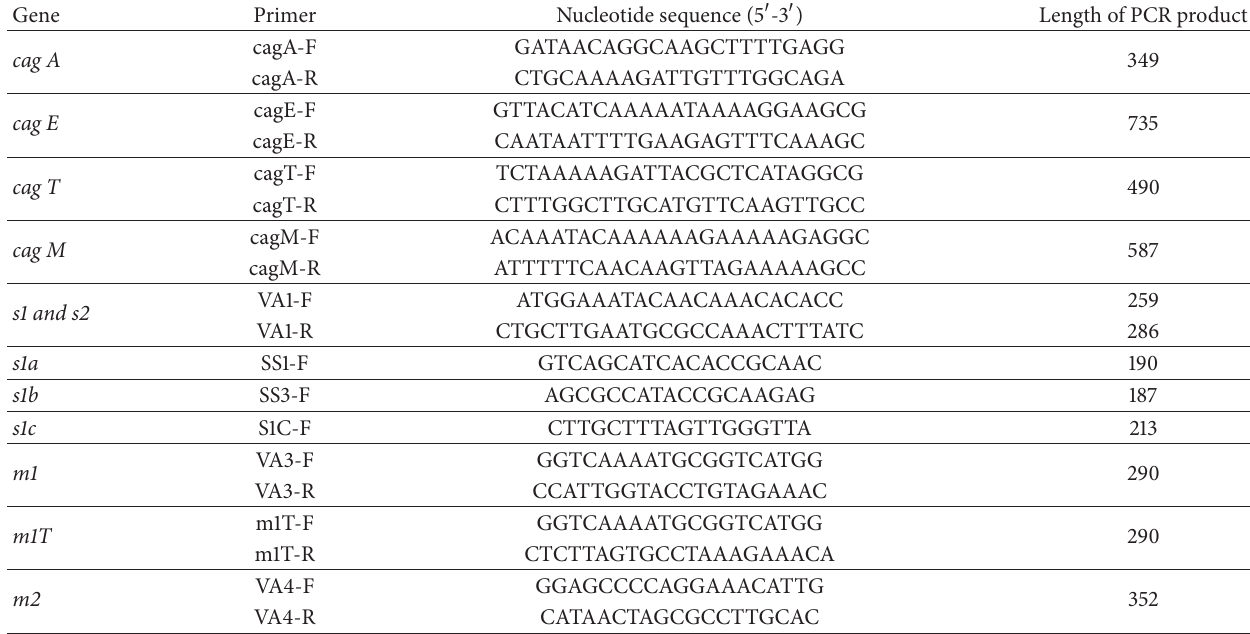
Table 1: PCR primers used in this study.